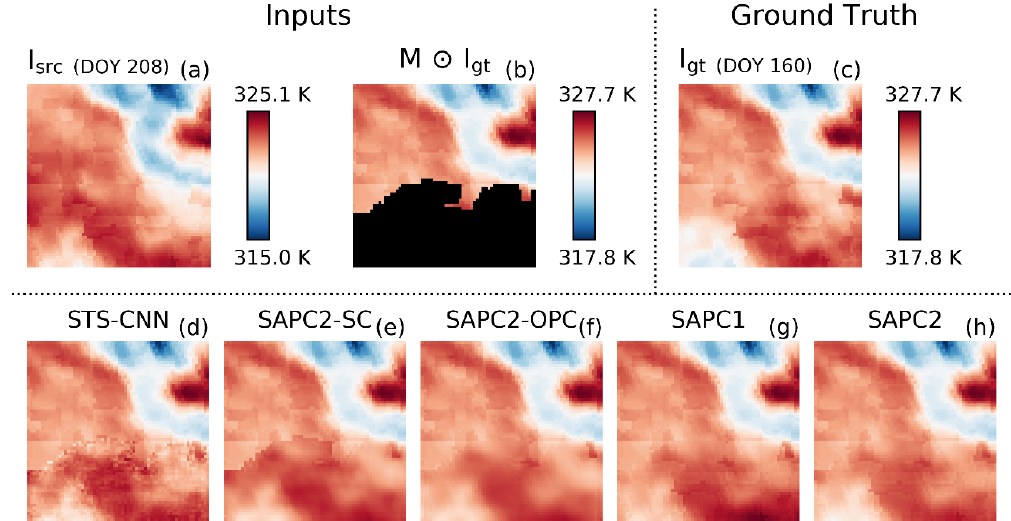
Figure 14. The same as Figure 9 but for Case 6 (acquisition DOYs for source and target inputs are 208 and 160, respectively). The masked fraction of the target image ( b ) is 0.407. The correlation coefficient between source ( a ) and ground truth ( c ) images is 0.839.